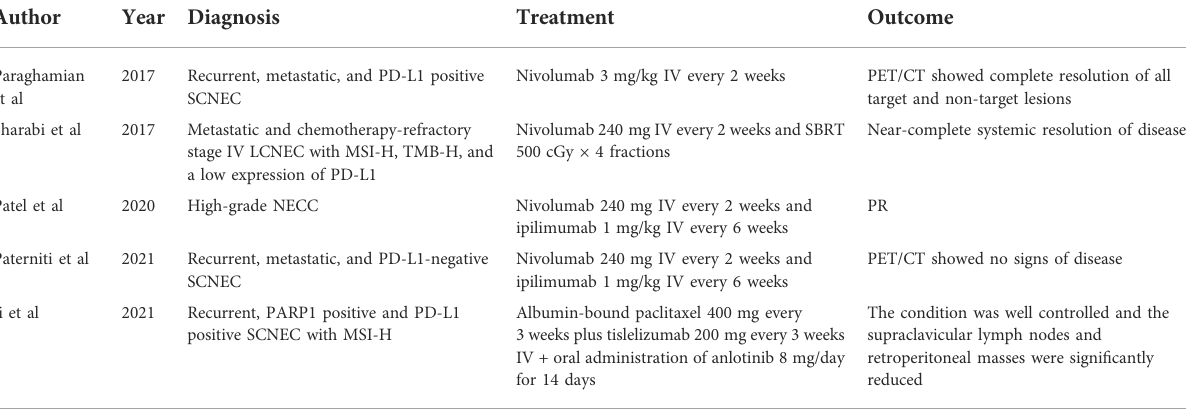
TABLE 1 Individual case reports with positive outcomes observed following therapy with PD-1/PD-L1 inhibitors in